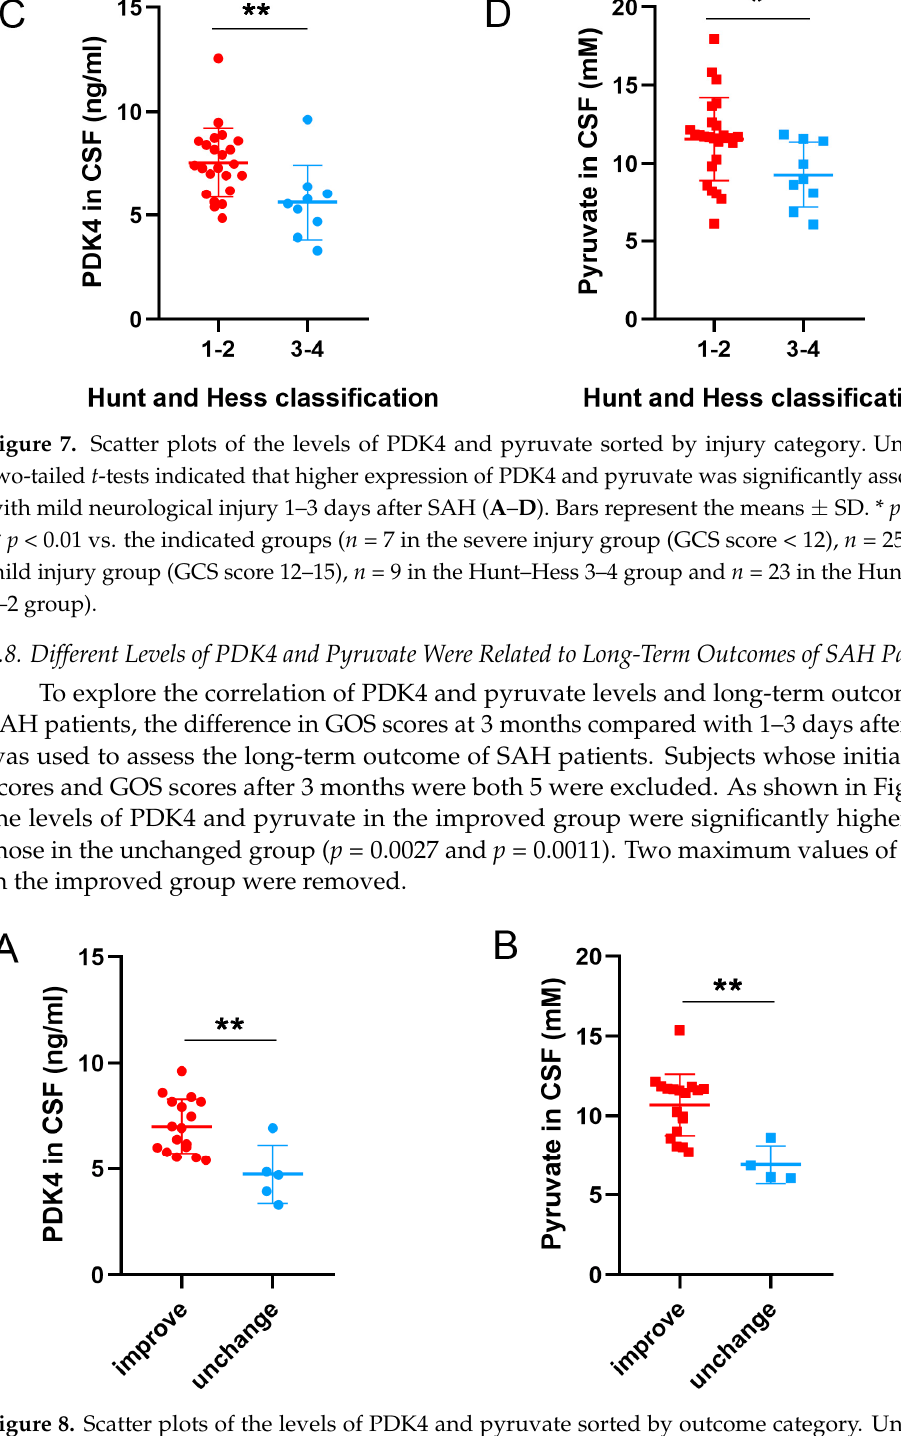
Figure 8. Scatter plots of the levels of PDK4 and pyruvate sorted by outcome category. Unpaired two-tailed t -tests indicated that higher expression of PDK4 and pyruvate was significantly associated with an improved outcome 3 months after SAH ( A , B ). Bars represent the means ± SD. ** p < 0.01 vs. the indicated groups ( n = 5 in the unchanged group and n = 17 in the improved group).